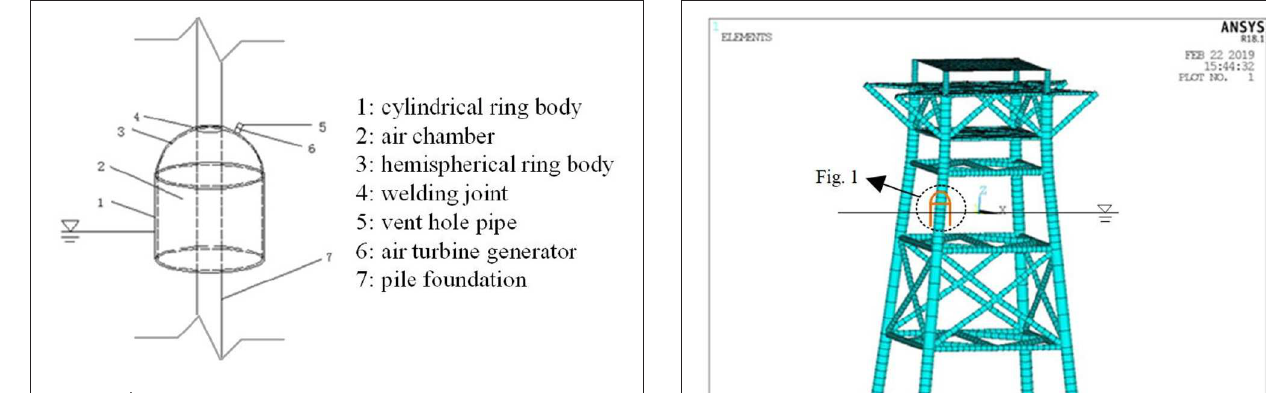
FIGURE 1 | Device sketch.